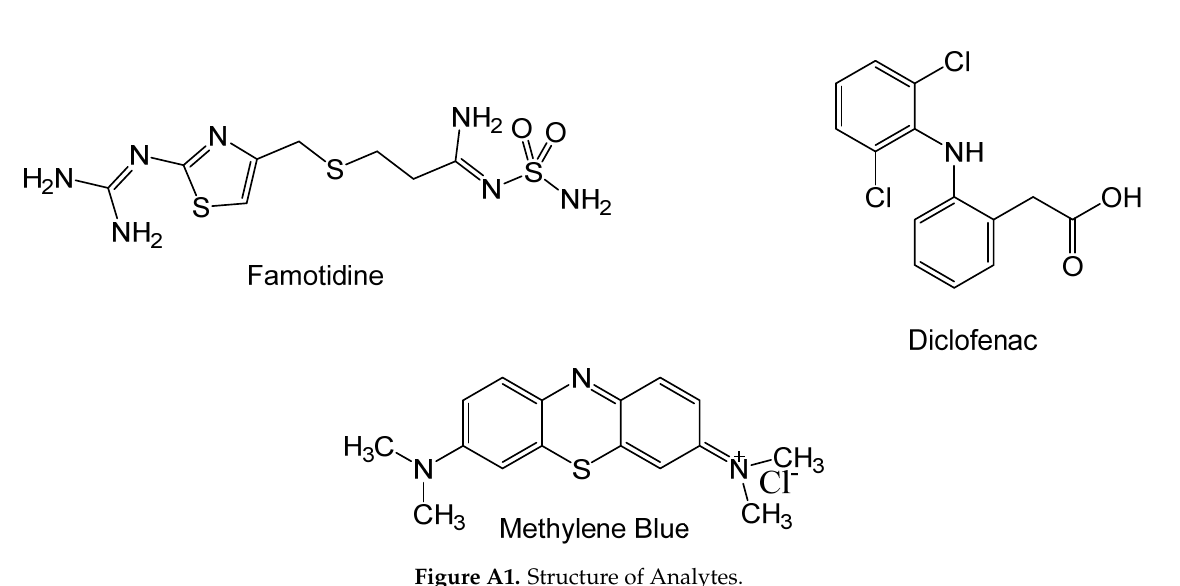
Figure A1. Structure of Analytes.